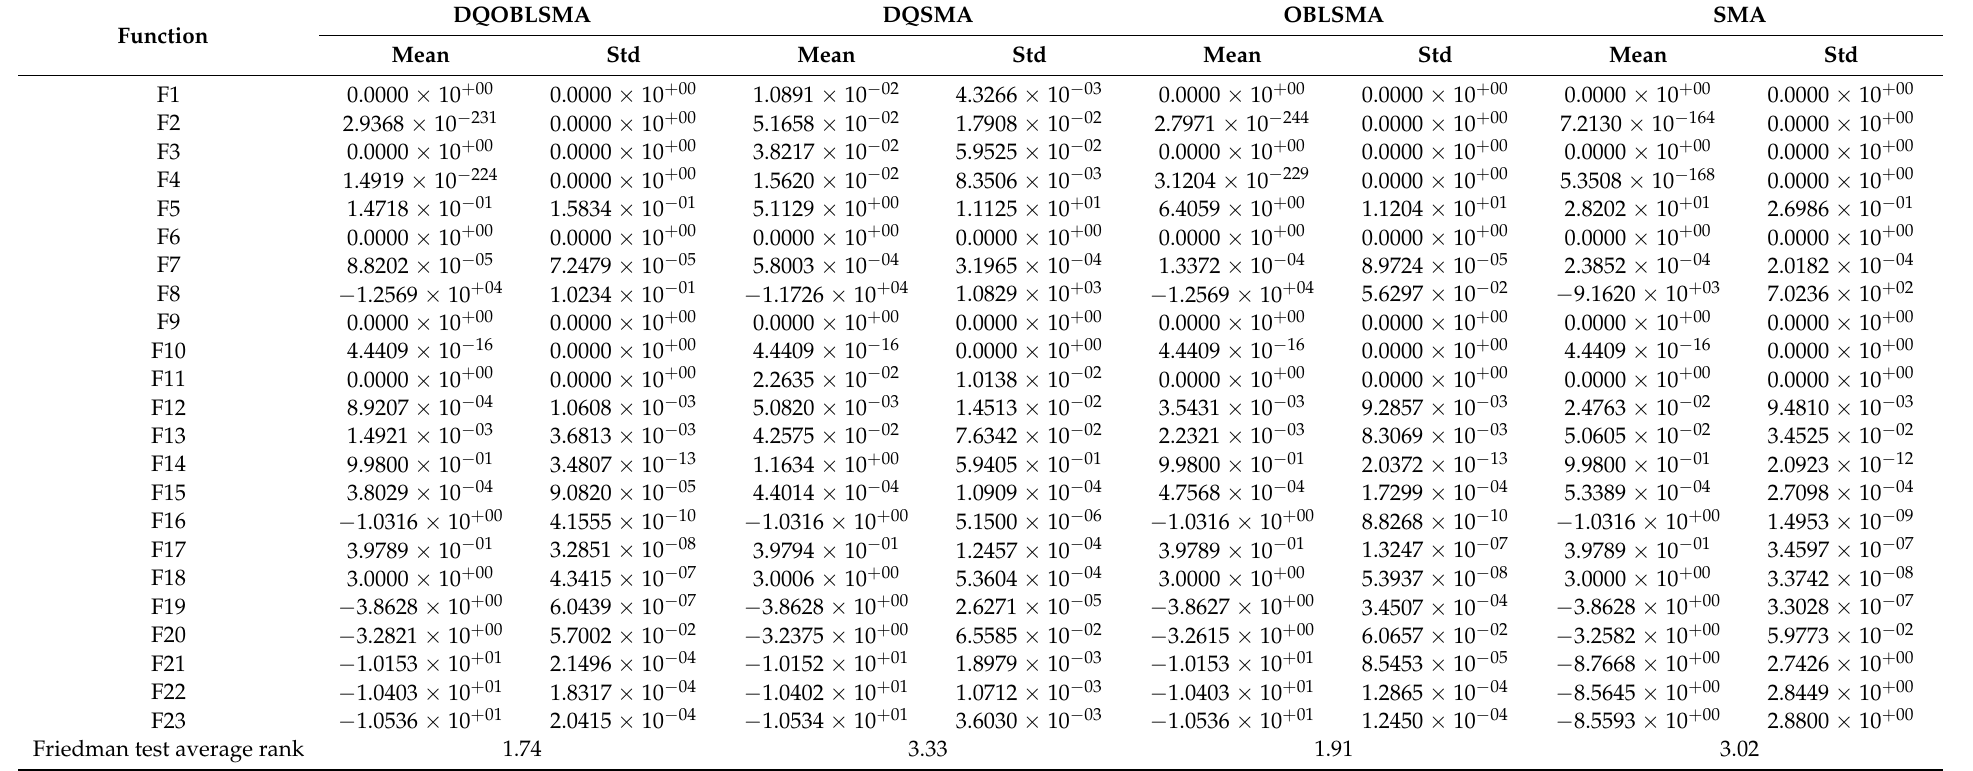
Table 4. Search results (comparisons of the DQOBLSMA, DQSMA, OBLSMA,